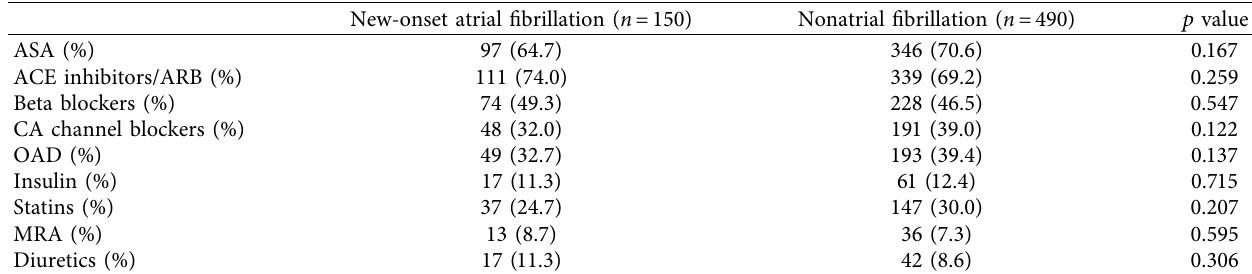
Table 5: Medications taken by all patients. New-onset atrial fibrillation ( n �